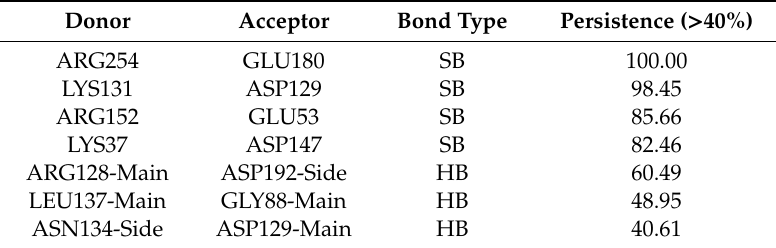
Table 1. Persistence of the SB and HB found within the kinase domain of LmJean3 during the molecular dynamics’ simulation (20 ns). See Tables S2 and S3 for an exhaustive list of all the possible interactions found during the